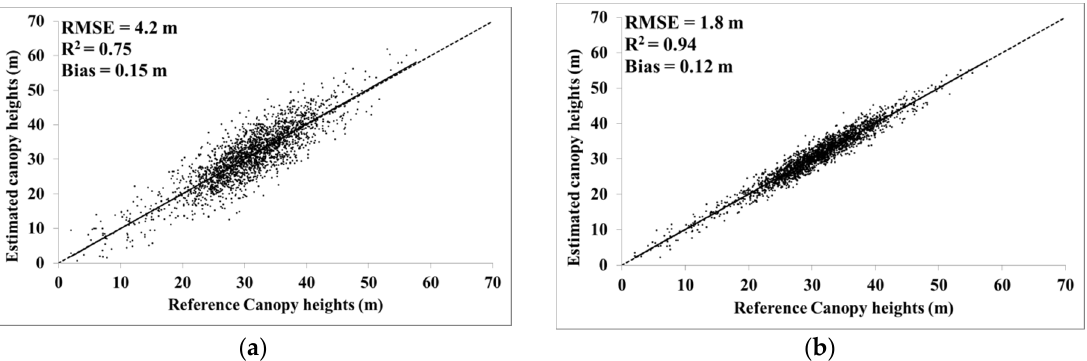
Figure 6. Comparison between the reference canopy heights of the verification datasets and the canopy height estimates using Random Forest regressions and residual-kriging: ( a ) GLAS dataset; and ( b ) LD_cal dataset.